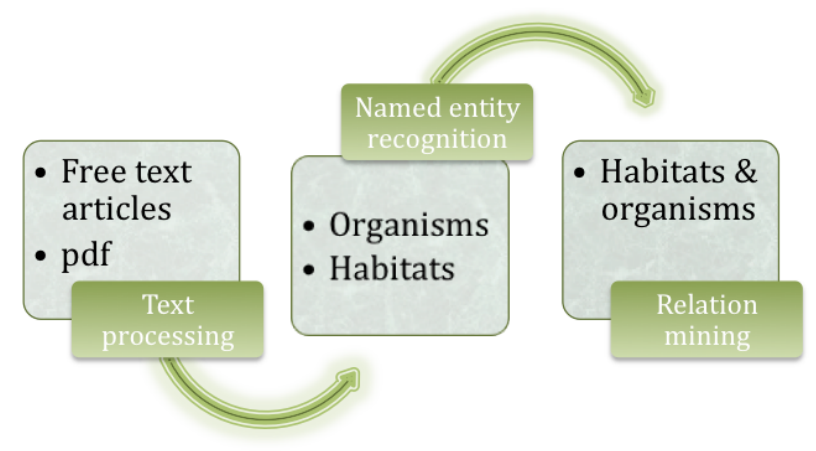
Figure 1: Overview of our